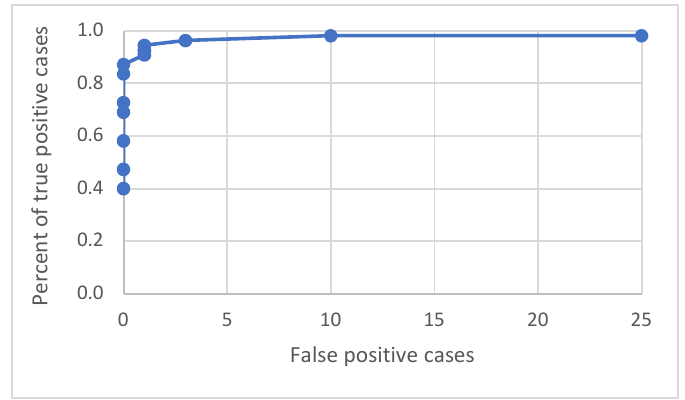
Figure 20. ROC curve for various detection probability thresholds in the range of 0.05 to 0.7.